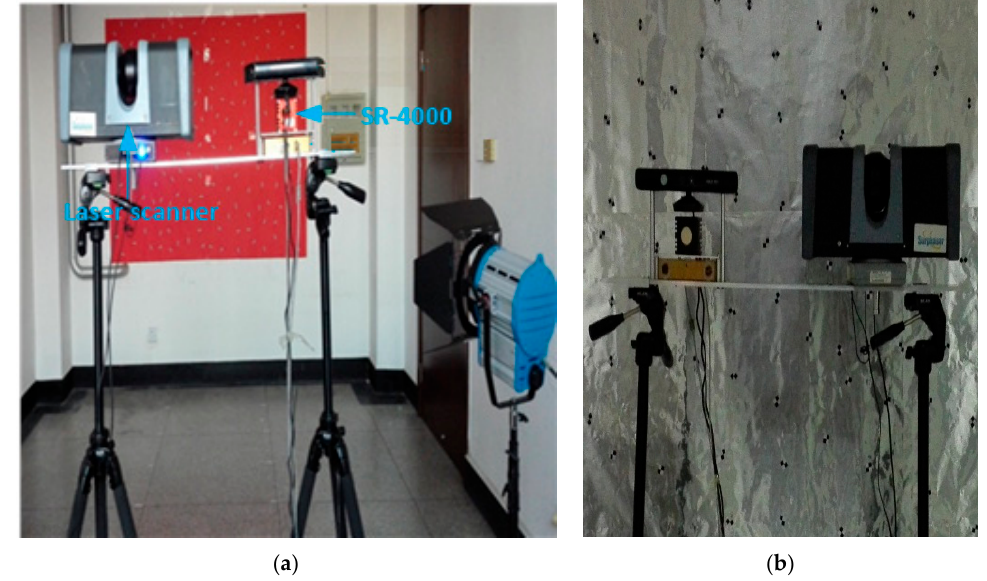
Figure 3. Experimental scene. ( a ) Experimental scene; ( b ) Camera bracket.